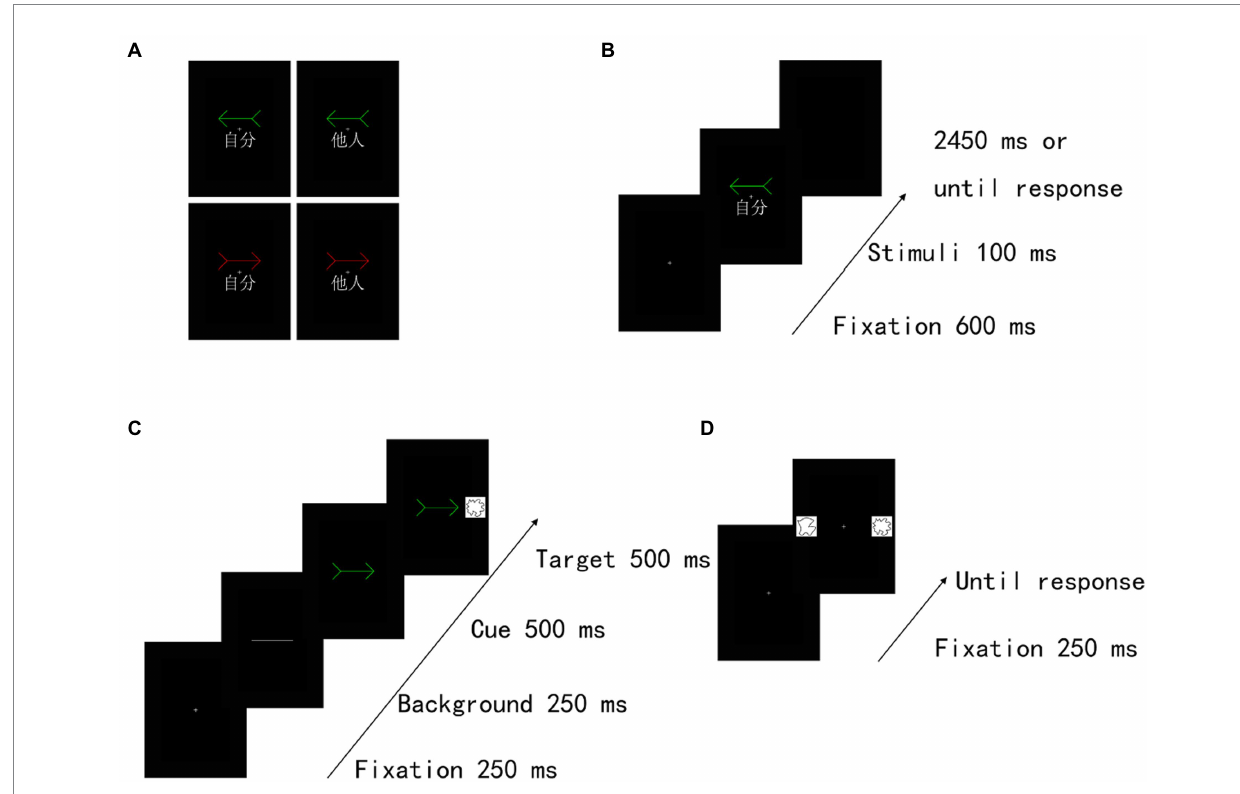
FIGURE 1 Experimental task structure in Experiment 1. (A) Examples of self-and other-arrow pair stimuli. Illustration of stimuli presented in the (B) training task, (C) cueing task and (D) recognition task. Two different colour arrows (i.e., red and green) were associated with the “self” or “other” words in the training task. Subsequently, a cueing task and a recognition task were implemented. In the cueing task, the participants were instructed to indicate as quickly and accurately as possible whether the target was presented on the left or right side by pressing the corresponding key (judge the location of the target). The target was equally likely to be presented on the same (valid cue condition) or opposite (invalid cue condition) side of the cue stimulus. The task consisted of 4 conditions, including valid and invalid conditions with self-and other-referential cues. In the recognition task, the participants were instructed to choose which of two shapes was displayed regardless of the location of the target in the cueing task. The recognition task consisted of 4 conditions, validity in the cueing task (valid and invalid cue condition) × self referentially in the cueing task (self-and other-reference conditions). The familiar shape was presented on the same (valid cue condition) or opposite (invalid cue condition) side as the self-or other-referential arrow cue in the cueing